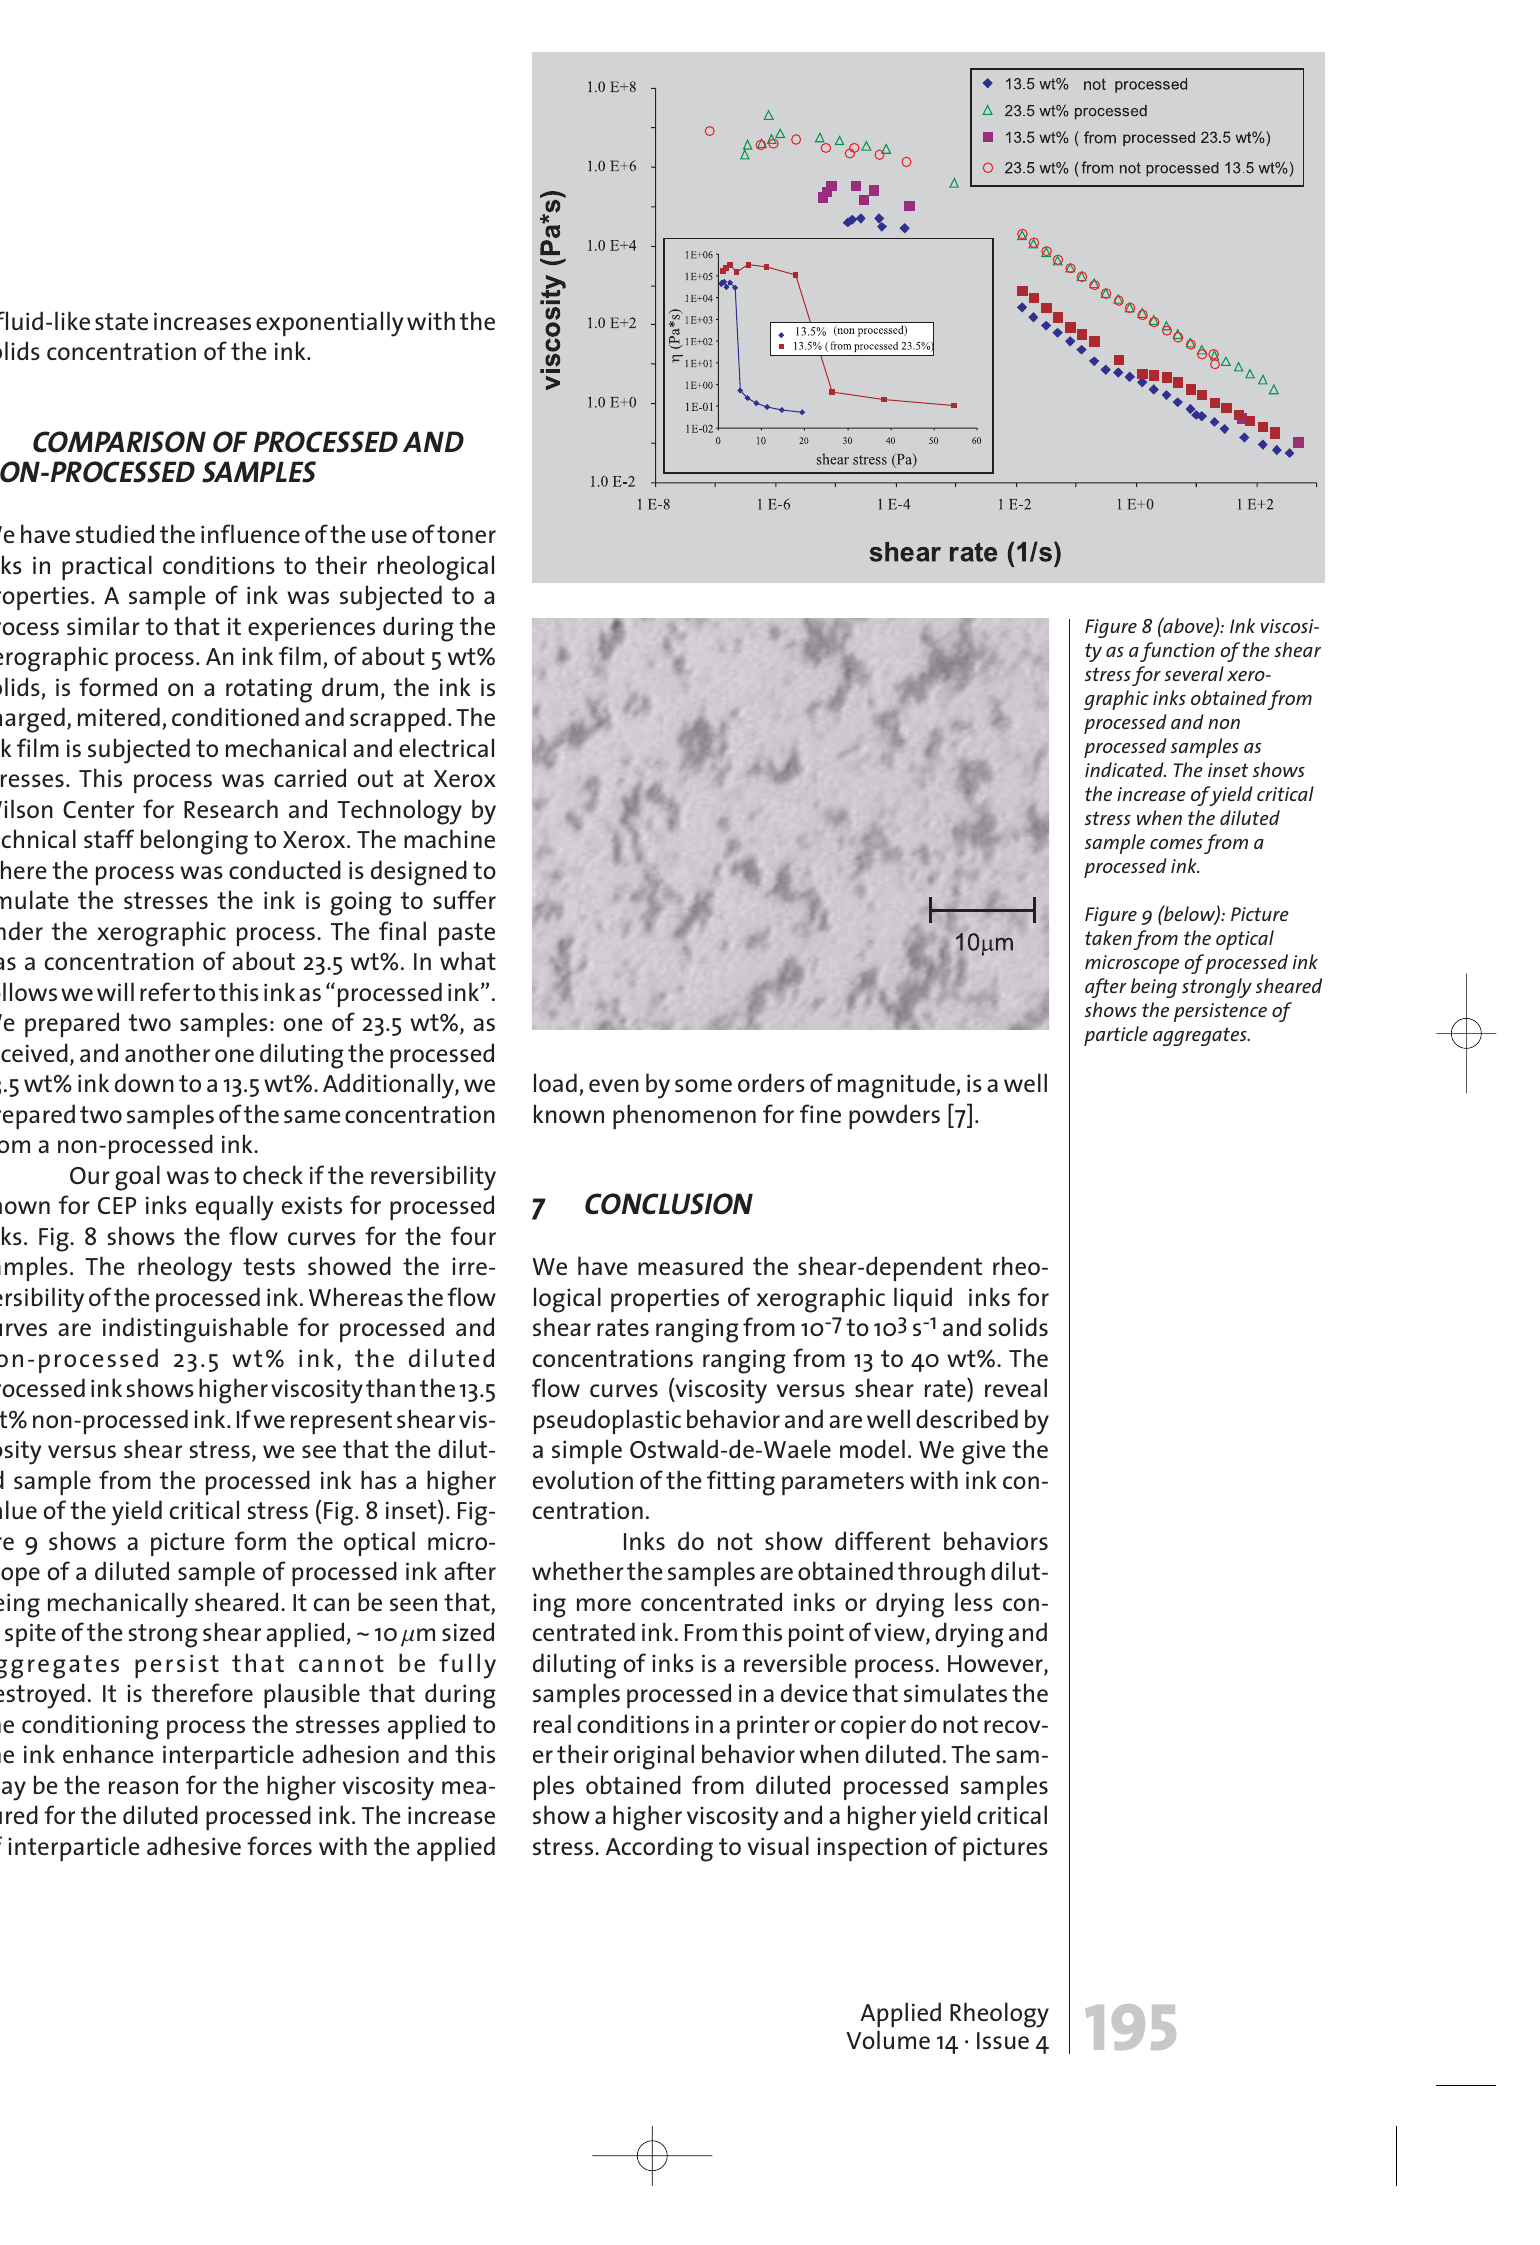
Figure 8 (above): Ink viscosi- ty as a function of the shear stress for several xero- graphic inks obtained from processed and non processed samples as indicated. The inset shows the increase of yield critical stress when the diluted sample comes from a processed ink. Figure 9 (below): Picture taken from the optical microscope of processed ink after being strongly sheared shows the persistence of particle